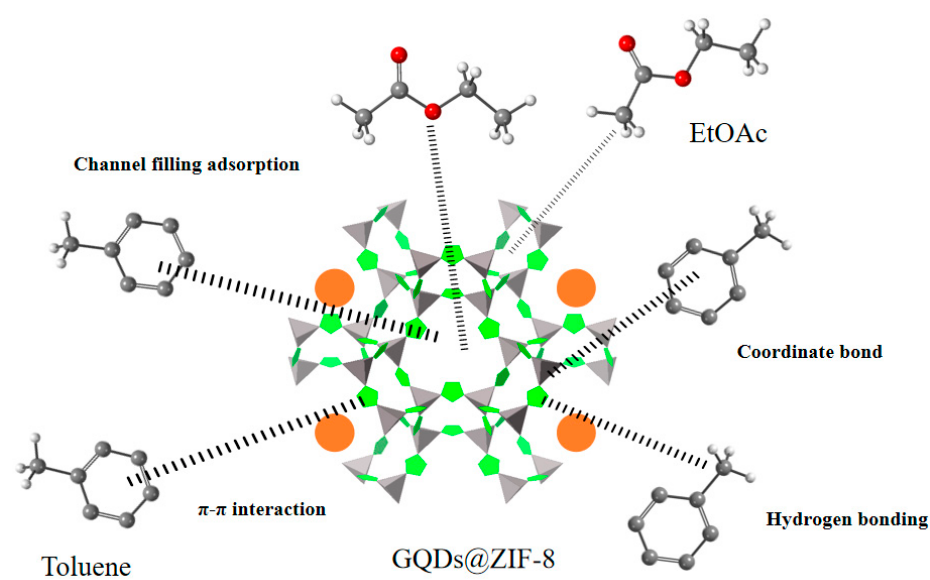
Figure 18. Adsorption mechanism illustration of the GQDs@ZIF-8 composites.